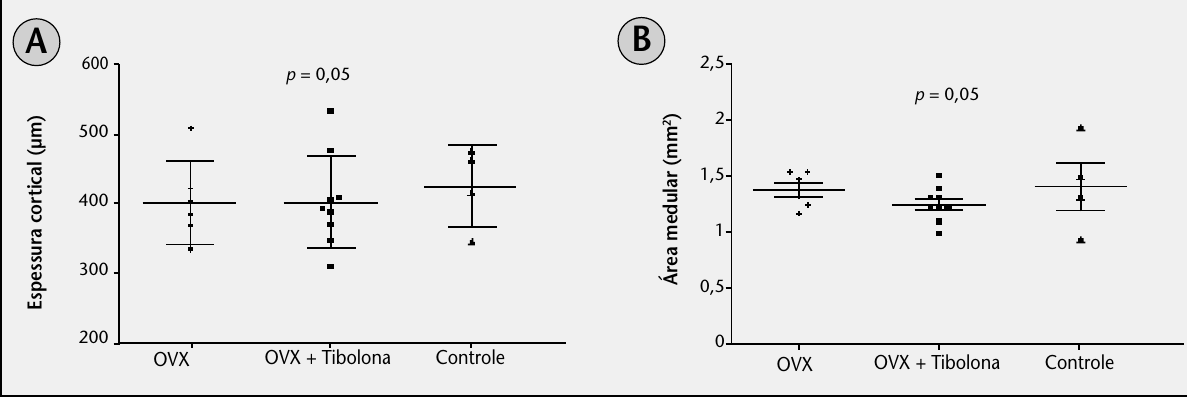
Figura 6 – Histomorfometria da diáfise tibial. (a) Espessura cortical; (b) área medular. Teste Kruskal-Wallis e